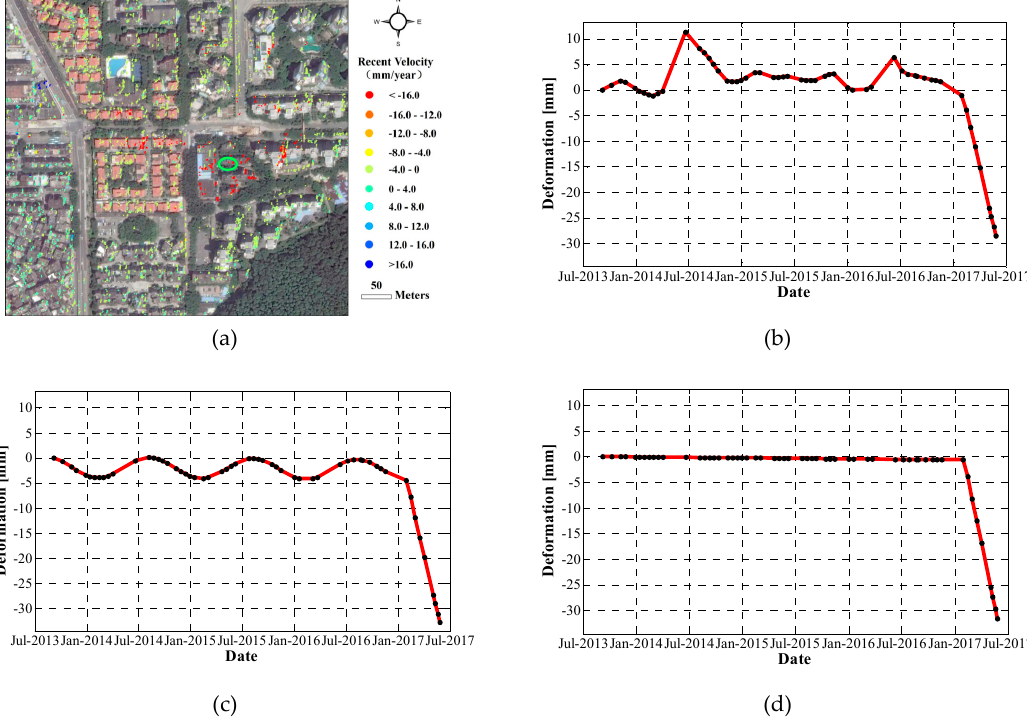
Figure 10. ( a ) PS recent velocity measurements in area A of Figure 9b; ( b ) measured deformation evolution of the PS circled in green in ( a ); ( c ) sum of periodic and piecewise linear components of the PS displacement; ( d ) piecewise linear component of the PS displacement.